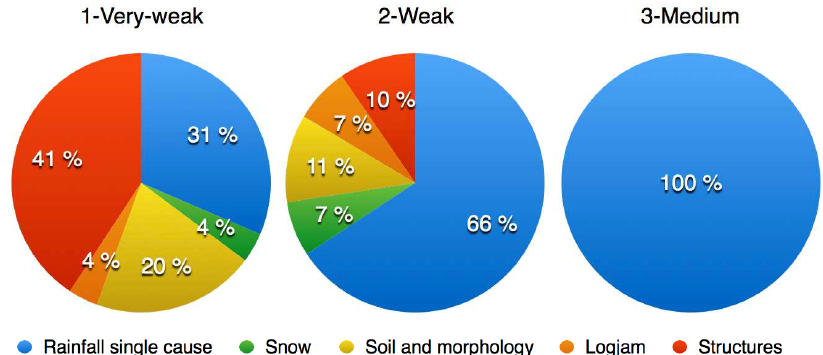
Figure 5. Distribution of the torrential flooding causes for 133 reported RTM events for which a narrative of causes is proposed. We distinguish five types of causes: rainfall as the single cause of the flood (blue), snow melt (green), soil moisture and river morphology (yellow), logjams blocking the torrent (orange), and counter-efficient structure protection (red). The proportions are given for the three RTM classes of intensity that are attributed to the considered basins over the study period (the single 4-high intensity event that occurred in 1867 has no narrative about